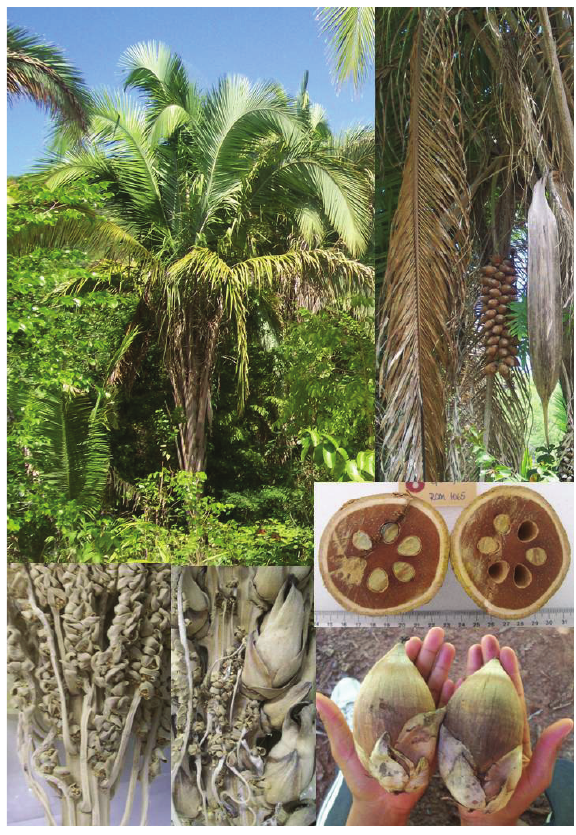
Figure 2: A figure used during the interviews in the Kalunga community Engenho II, Cavalcante, GO, central western Brazil. Attalea speciosa (coconut